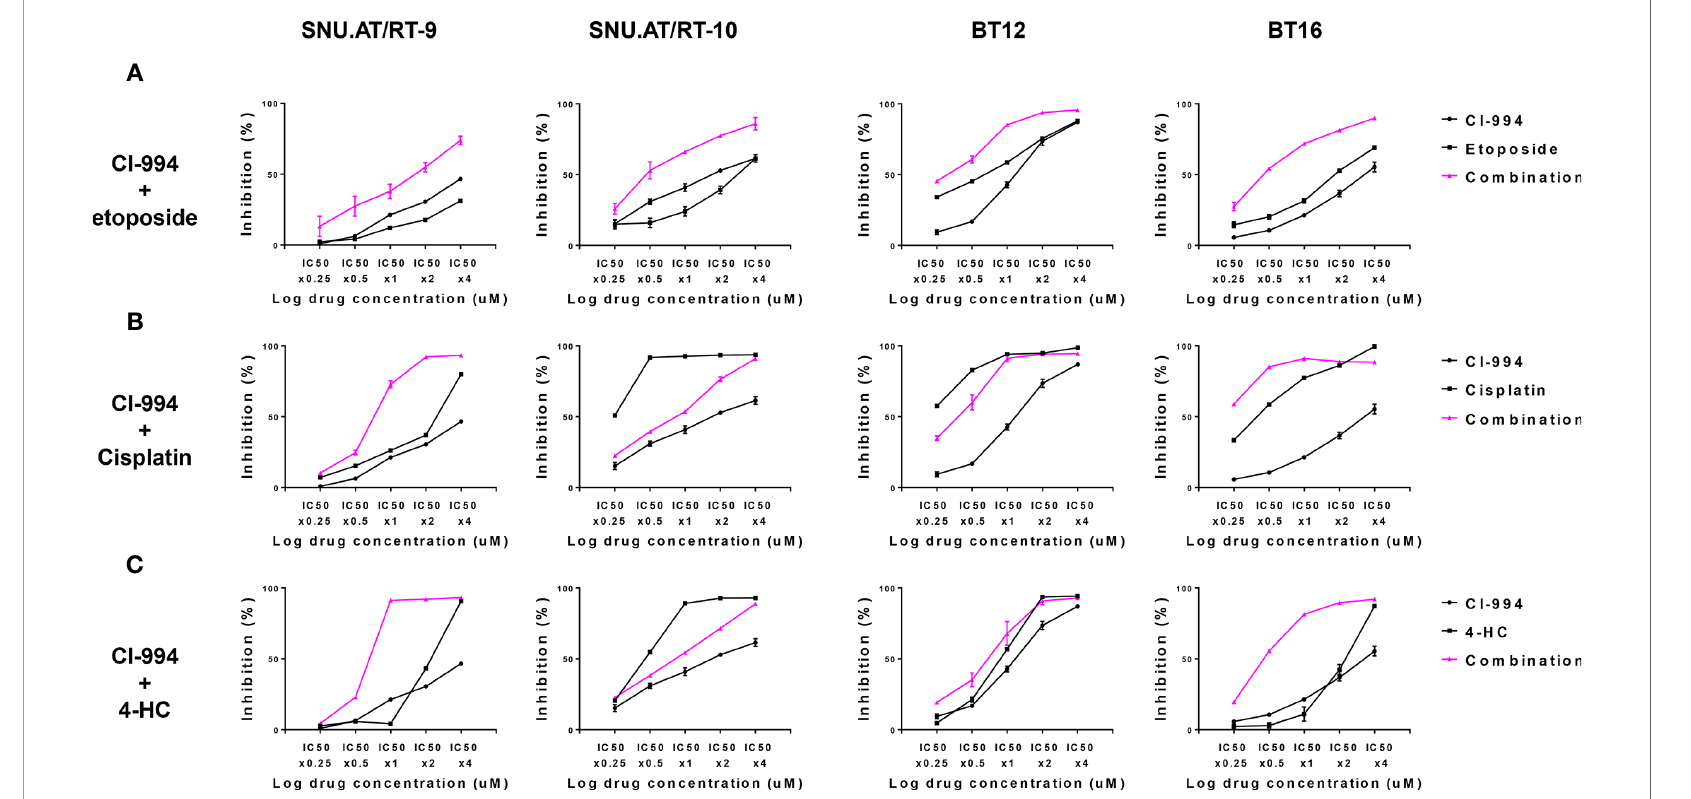
FIGURE 3 | Comparative evaluation of the combination effect of CI-994 with conventional anticancer drugs. Curve shift analysis of CI-994 with conventional drugs (etoposide, cisplatin and 4-HC) in AT/RT cells shows that the degree of left shift represented the amount of synergism associated with the indicated drug combination. Single treatment: Black lines, Combination treatment: Pink lines. (A) In response to the combination treatment of CI-994 with etoposide, synergistic effects were observed and inhibited the growth potential of all AT/RT cells in a dose-dependent manner. (B, C) The combination treatment of CI-994 with cisplatin or 4 HC exerted cell type-speci fi c effects. Synergistic effects were observed in the cells treated with the combination of CI-994 with cisplatin only for SNU.AT/RT-9 cells and in cells treated with the combination of CI-994 with 4-HC for SNU.AT/RT-9 cells and BT-16